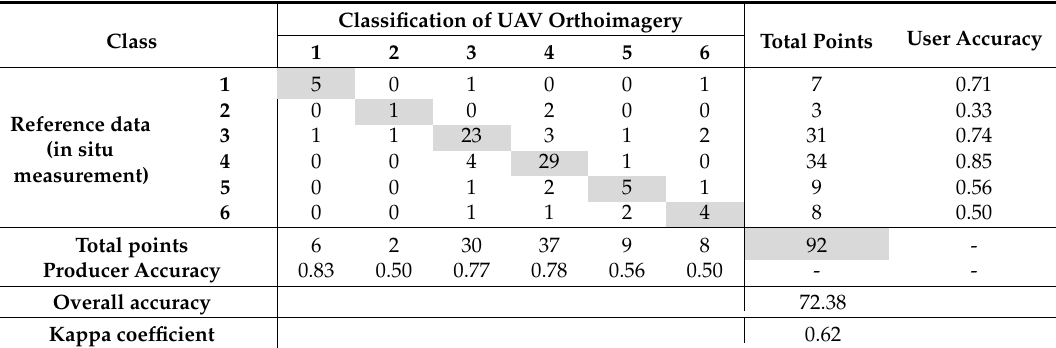
Figure 7 described all of the misclassified samples and the corresponding in situ photographs. Circles are incorrectly classified by the sun-glint effect and cloud. Triangles are misclassified by shellfish beds. Other misclassified samples were caused by surface water.